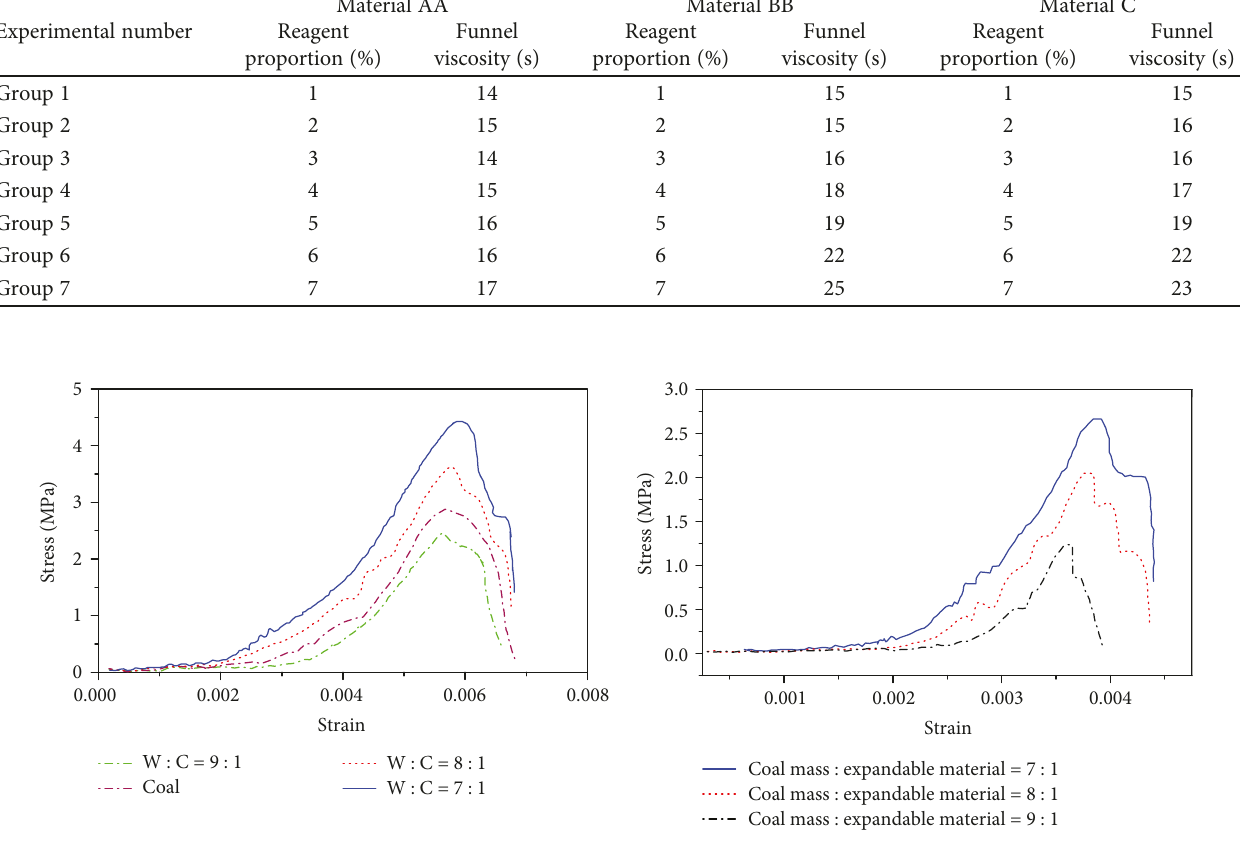
Table 1: In fl uences of materials AA, BB, and C on the funnel viscosity of expandable slurries with high water content. Experimental number